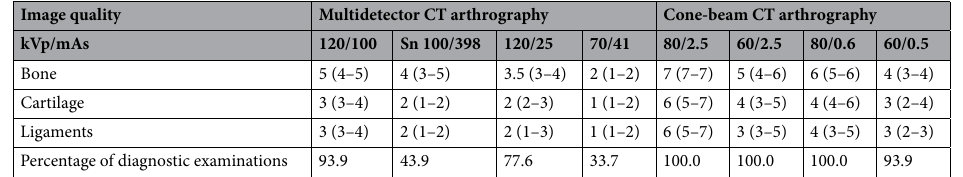
Table 2. Image quality ratings. Pooled image quality ratings of seven observers for bilateral wrist arthrograms in eight cadaveric specimens. Results are presented as median values with interquartile ranges in parentheses. kVp kilovoltage peak, mAs milliampere-seconds, Sn tin